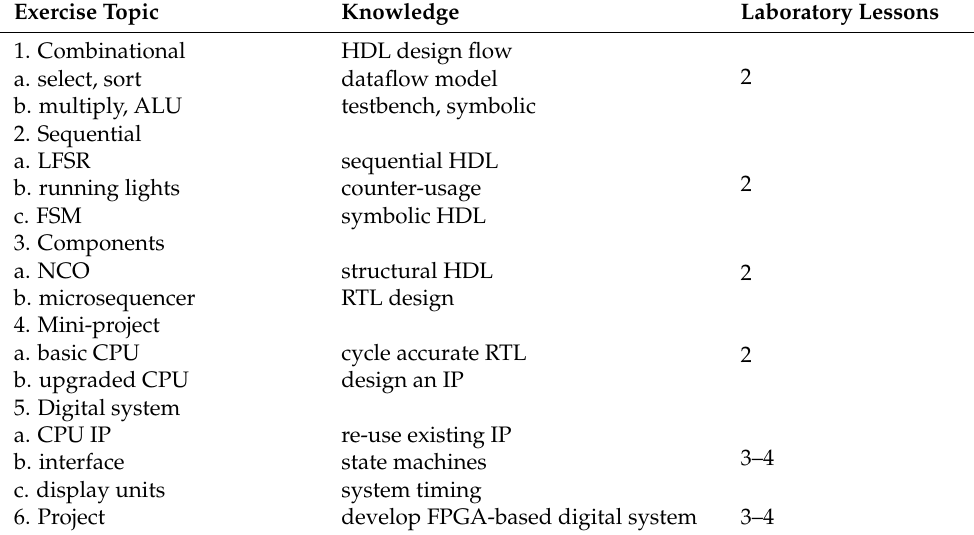
Table 2. DESD laboratory